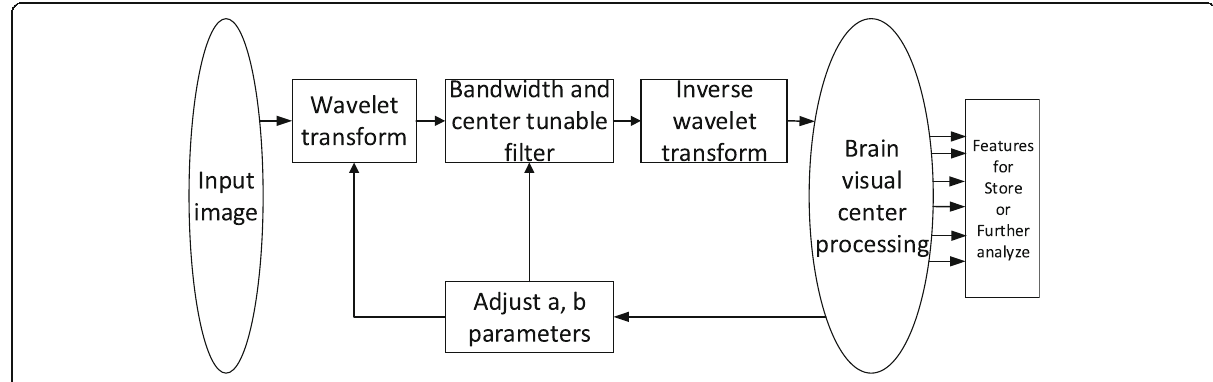
Fig. 6 Visual information extraction model based on wavelet